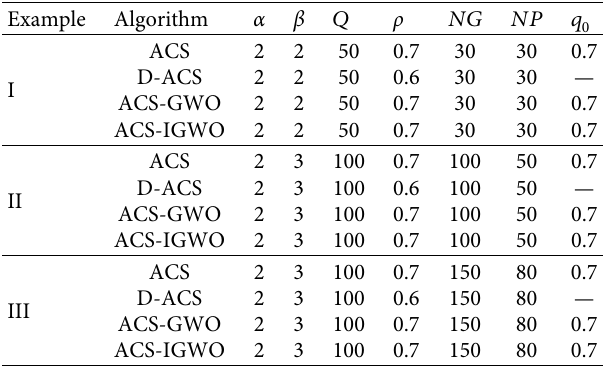
Table 13: Parameters’ combination of the four algorithms.